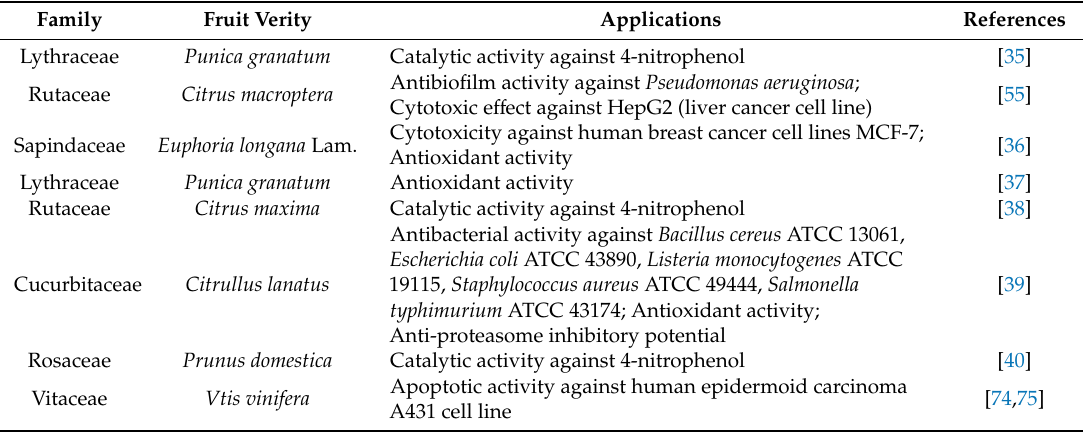
Table 4. Applications of gold NPs synthesized from various fruit